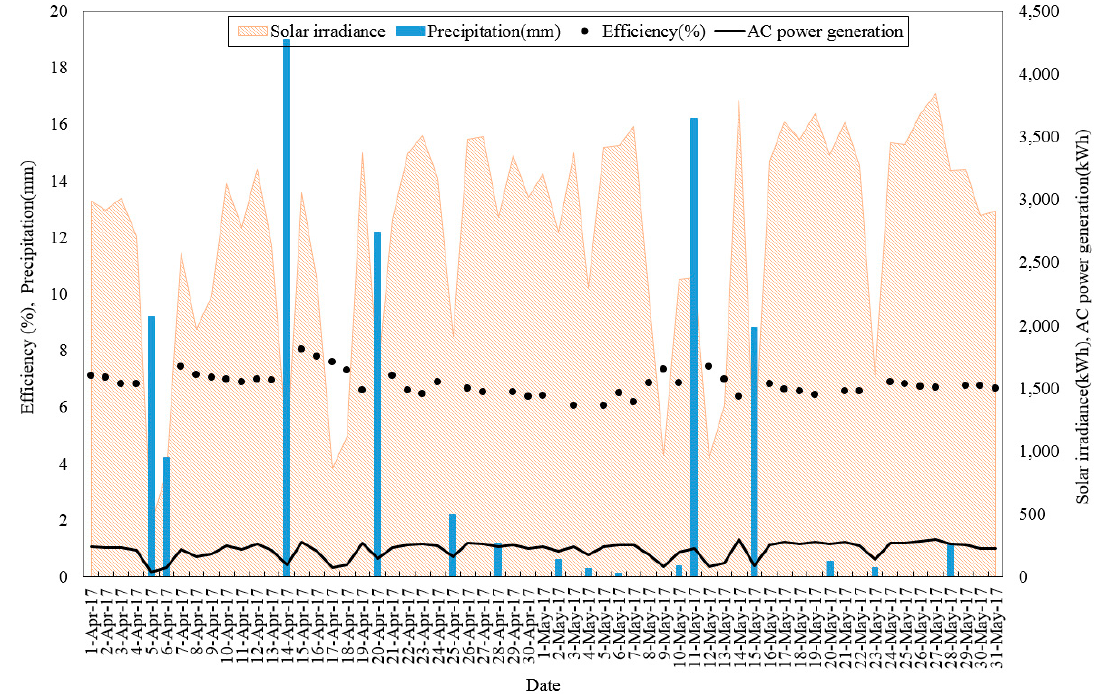
Figure 15. Daily e ffi ciency and daily precipitation of the Inv-15 array. Energies 2019 , 12 , x FOR PEER REVIEW Figure 15. Daily efficiency and daily precipitation of the Inv-15 array. Table 4. Power generation efficiency comparison before and after precipitation occurrence.